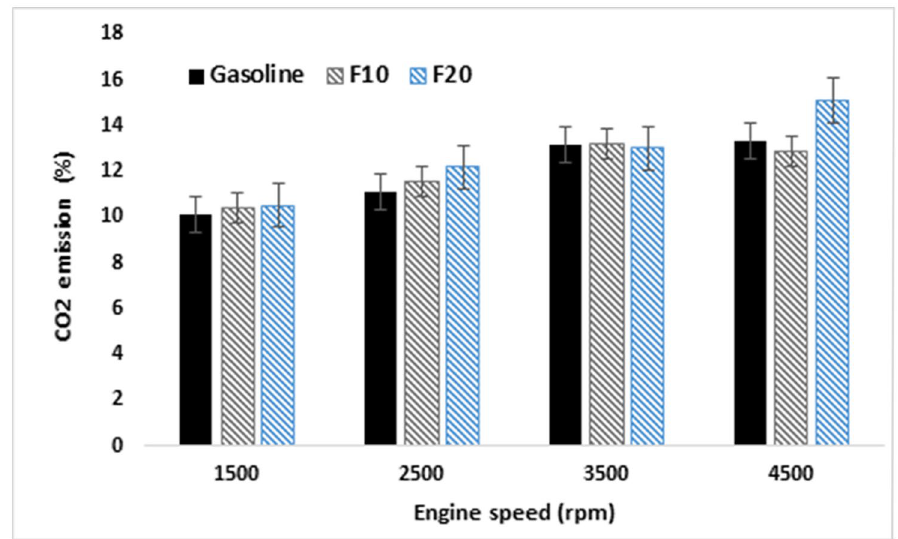
Figure 14. Variation of CO2 emissions against engine speeds and three different